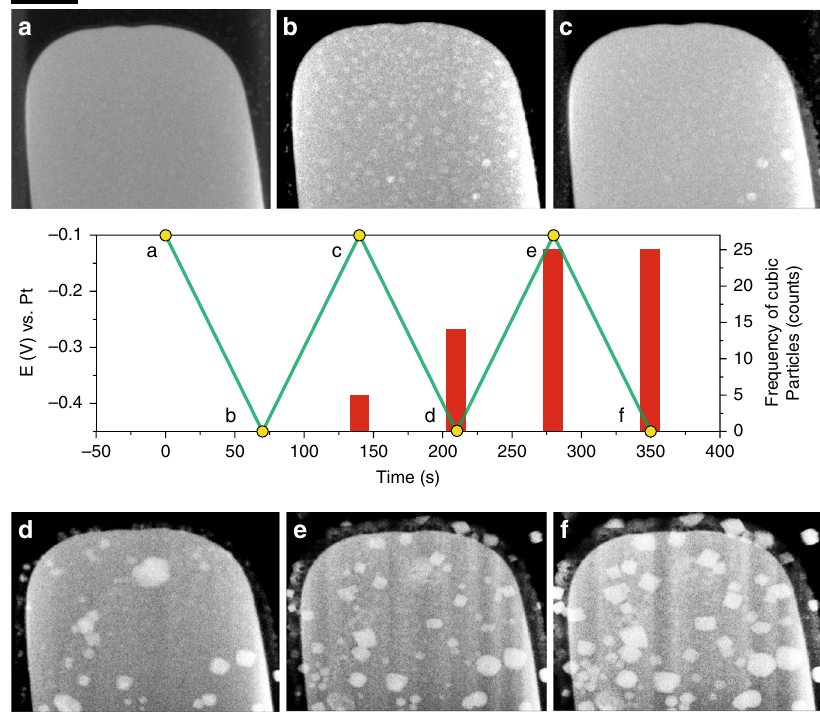
Fig. 3 Number of cubic particles observed with potential cycling. Potential (green line) and frequency of cubic particles (red columns) as a function of experimental time during electrochemical cycling. The images labeled as a – f correspond to STEM images of the working electrode acquired at different potentials as indicated by the yellow circles in the plot. The vertical bars indicate the number of cubic-shaped particles observed at each point. The scale bars correspond to 1 µ